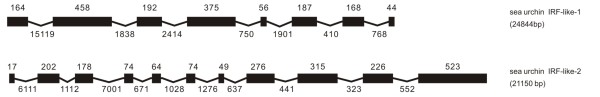
Predicted genomic structure of IRF-like genes in the sea urchin Strongylocentrotus purpuratus.